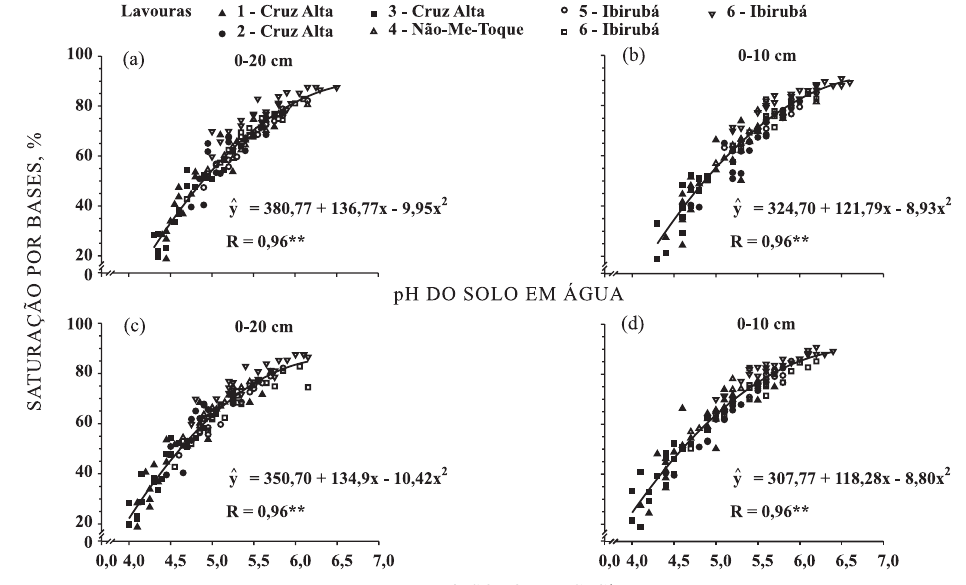
Figura 3. Relação entre o pH do solo determinado em água e em CaCl